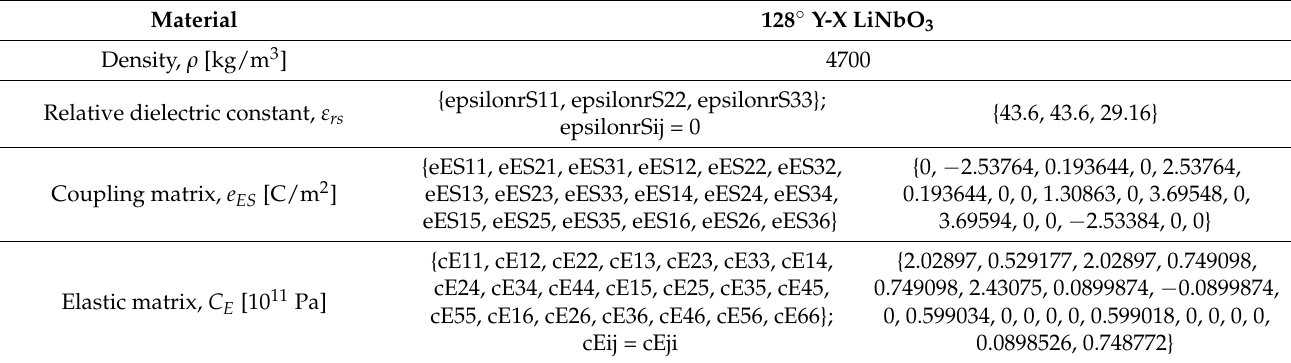
Table 2. Parameters of piezoelectric materials in the simulation model.